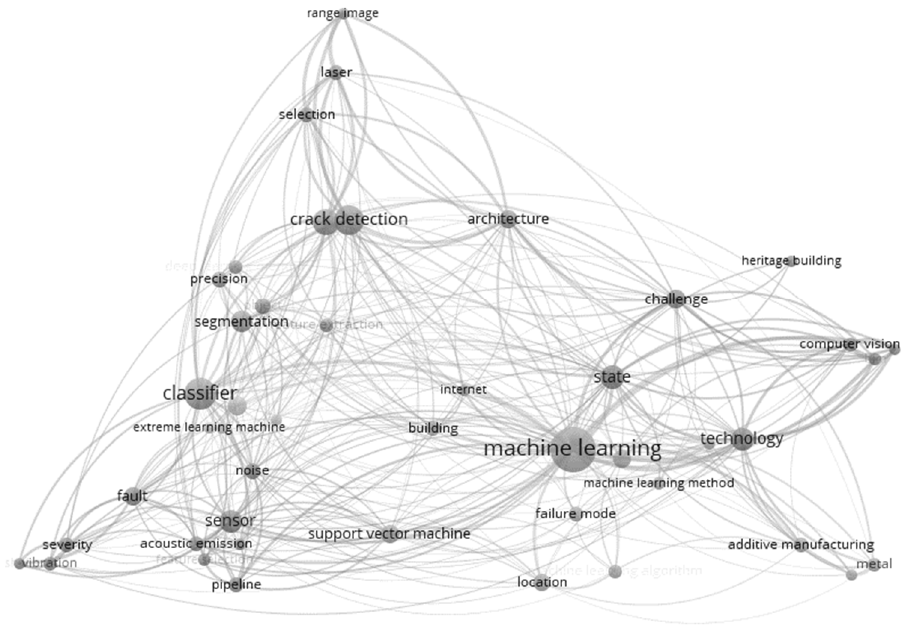
Figure 4. Keywords for Crack Detection.